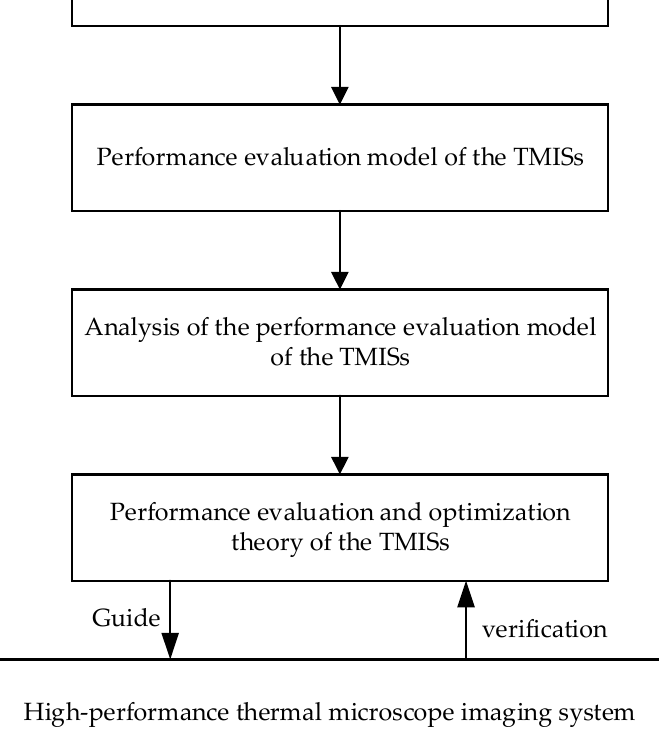
Figure 3. The block diagram of the research in this paper.